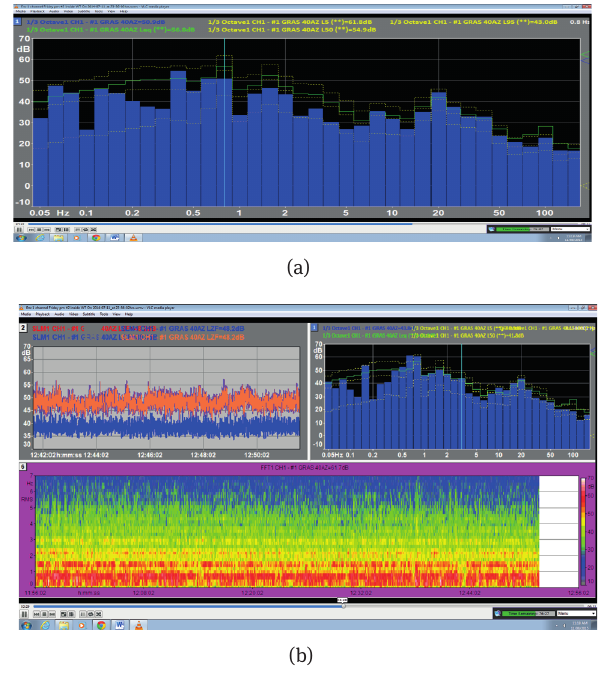
Fig. 1: Sample sound pressure levels recorded inside houses sev- eral kilometers away from wind farms (Rick James, personal commu- nication, October 2015). a) Sample sound pressure level (SPL) in dB vs. frequency in Hz for the infra-sound and lower frequency audible ranges recorded at a given time. b) Contours of recorded SPL in dB vs. frequency in Hz and time (time window of one hour, from 11:56 to